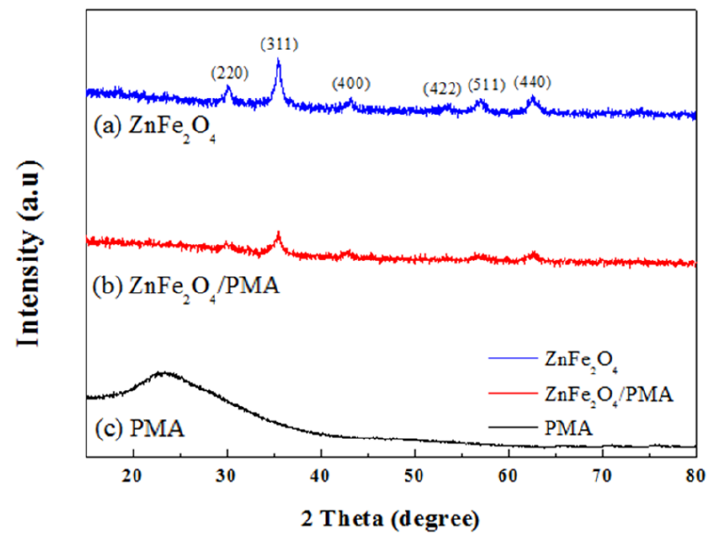
Figure 4. XRD spectra of ( a ) ZnFe 2 O 4 , ( b ) ZnFe 2 O 4 /PMA core-shell microspheres, and ( c ) PMA. The thermal behaviors of the particles and the mass percentage of PMA in the ZnFe 2 O 4 /PMA were examined by TGA. TGA confirmed the thermal stability of the ZnFe 2 O 4 and ZnFe 2 O 4 /PMA particles, as shown in Figure 5. The solid black line in Figure 5a is the curve for ZnFe 2 O 4 , and the red dot line in Figure 5b is the curve of ZnFe 2 O 4 - coated with PMA. In the case of ZnFe 2 O 4 in Figure 5a, a weight loss of about 3% occurred at about 250 ◦ C, indicating the decomposition of surfactants and residual organic chemi- cals [41]. As a result of the thermal decomposition of ZnFe 2 O 4 /PMA in Figure 5b, weight loss due to moisture occurred at around 100 ◦ C. After 300 ◦ C, a rapid weight loss of about 30% was observed due to the decomposition of ZnFe 2 O 4 /PMA. The main backbone of PMA surrounding the core started to decompose at a high temperature, and the curve decreased sharply. The final weight contents of ZnFe 2 O 4 and PMA in the ZnFe 2 O 4 /PMA were 60.5% and 39.5%, respectively.